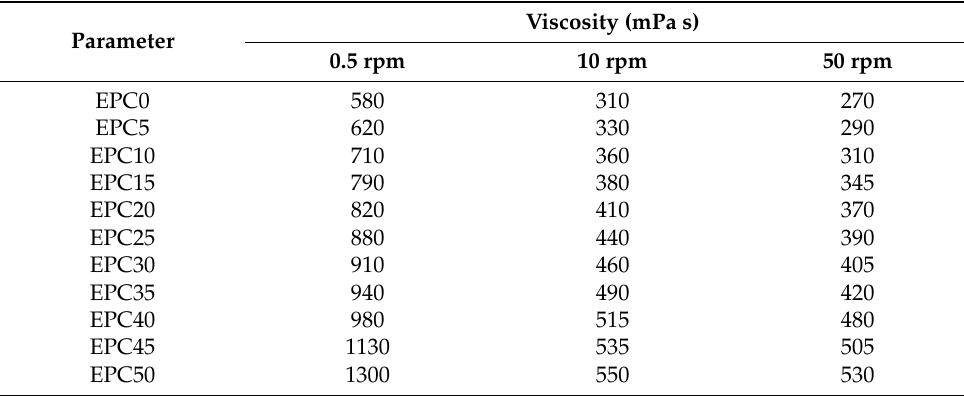
Table 9. Viscosity of polyol premixes at different shear